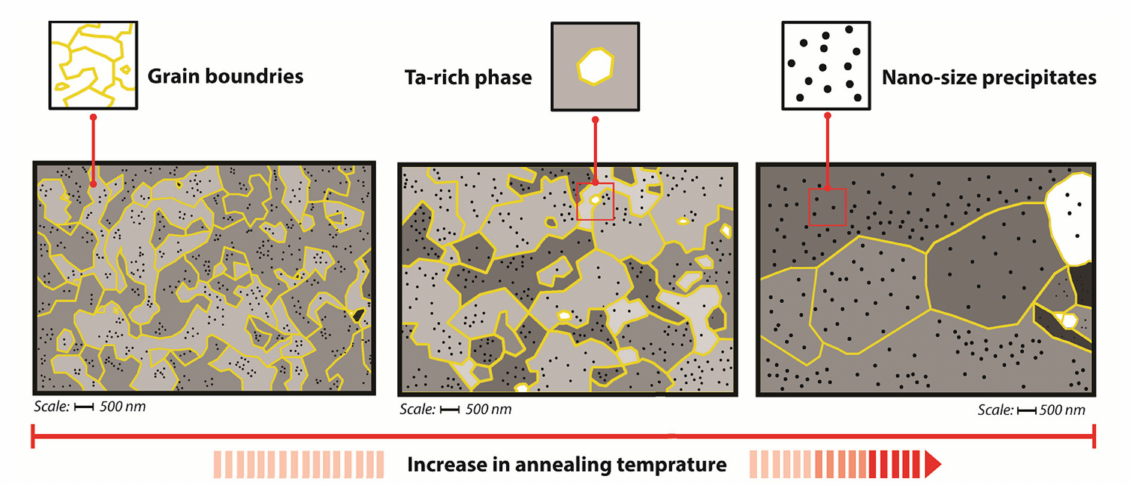
Figure 6. Schematic drawing of changes in microstructure occurring during annealing of the OPH